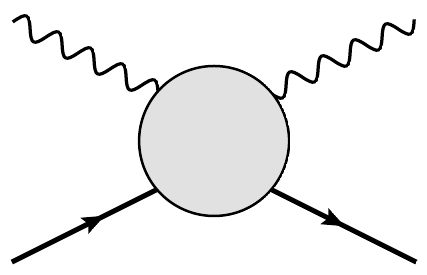
Figure 1 . The gravitational Compton scattering relevant as of the one-loop level. The gravitational Compton amplitude involves two massive spinning particles and two gravitons, where factorization constraints do not uniquely determine the amplitude for s > 2